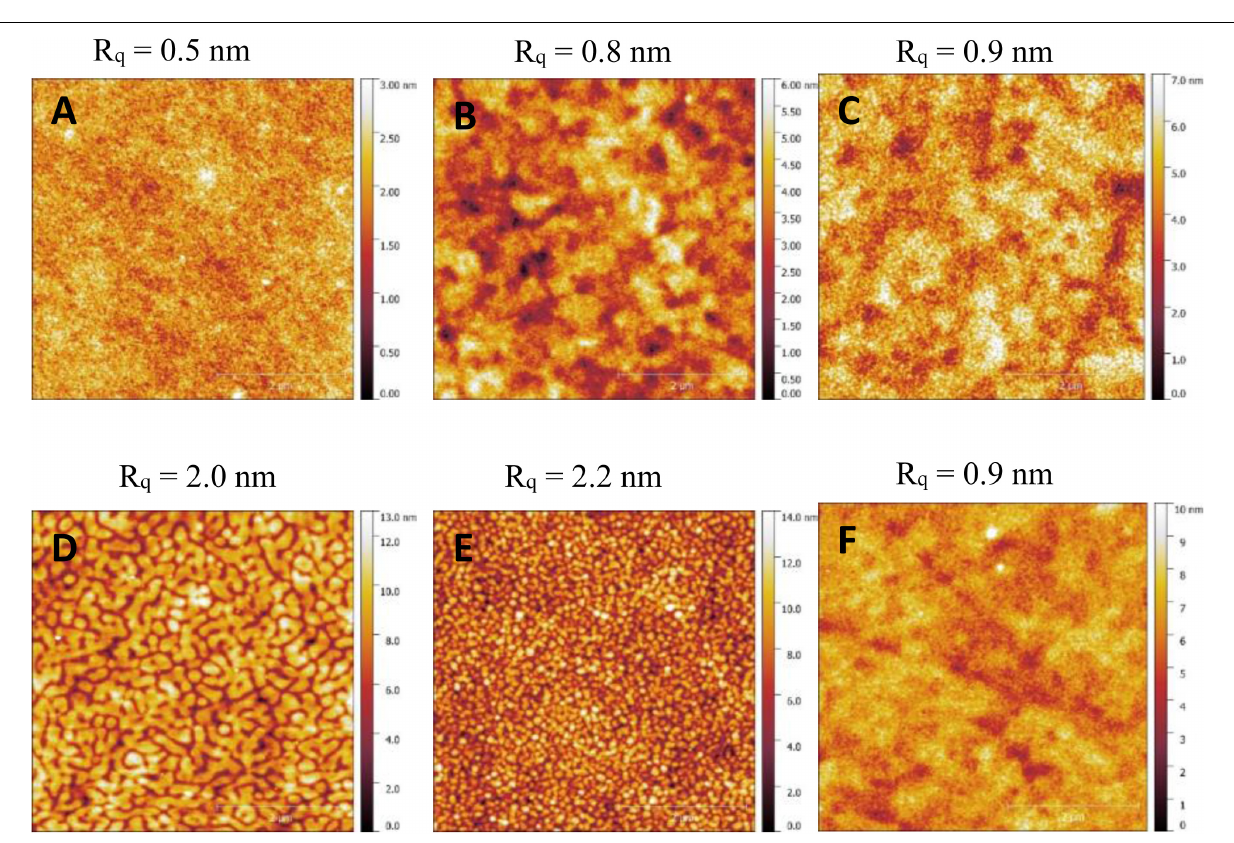
FIGURE 6 | × 5 µ M × 5 µ M AFM images of (A) TQ1A:PC 61 BM, (B) TQ1-50A:PC 61 BM, (C) TQ1-20A:PC 61 BM, (D) TQ1P4:PC 61 BM, (E) TQ1-50P4:PC 61 BM, and (F) TQ1-20P4:PC 61 BM films processed from the same solution as device